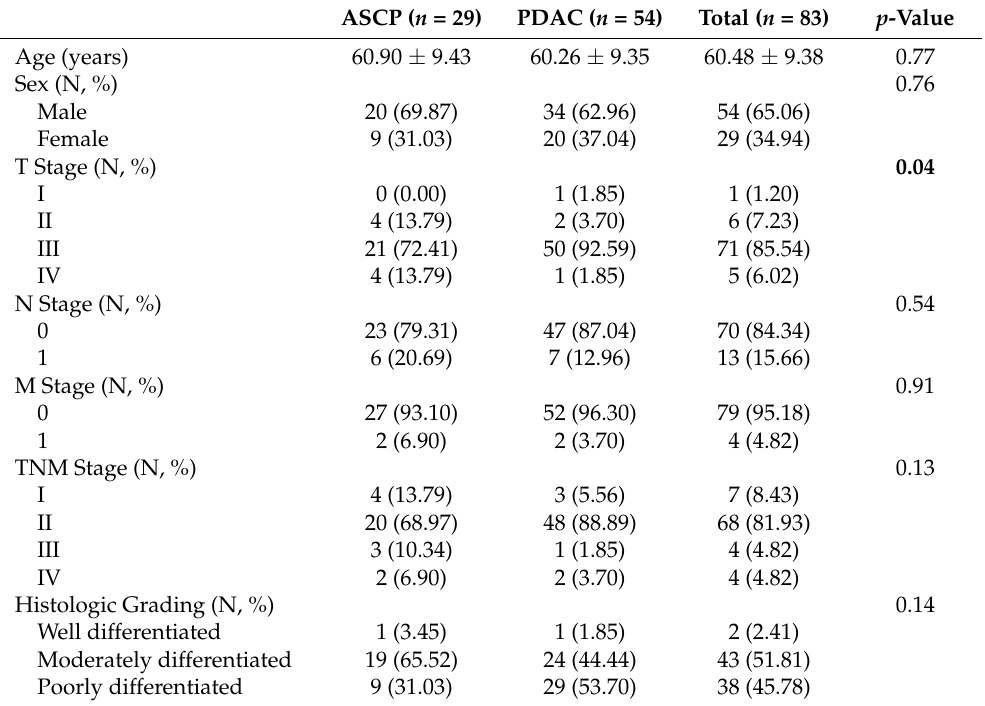
Table 1. Patient demographics and clinicopathologic factors ( n =